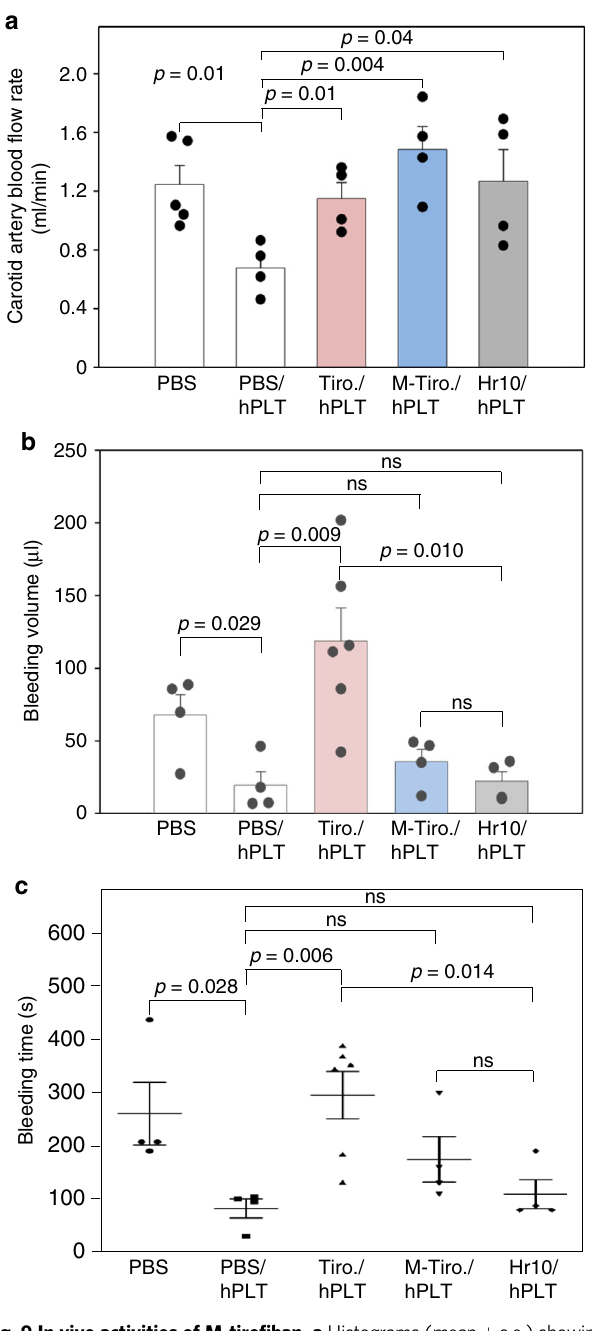
Fig. 9 In vivo activities of M-tiro fi ban. a Histograms (mean + s.e.) showing carotid artery blood fl ow over the 40-min observation period following redox- induced arterial injury. vWF RH/RH NSG male mice were either uninfused (PBS; n = 5) or infused with human platelets (hPLT) plus PBS ( n = 4), tiro fi ban (Tiro.; n = 4), M-tiro fi ban (M-Tiro.; n = 4), or Hr10 ( n = 4). b Blood loss (mean + s.e.) in vWF RH/RH NSG male mice uninfused (PBS; n = 4) or infused with hPLT plus PBS ( n = 4), tiro fi ban (Tiro.; n = 6), M-tiro fi ban (M-Tiro.; n = 4), or Hr10 ( n = 4). p values are indicated. c Bleeding time analysis (mean + / − s.e.) in vWF RH/RH NSG male mice treated as in Fig. 6b. Statistical tests by Student ’ s t -test, two-tailed; ns, not signi fi